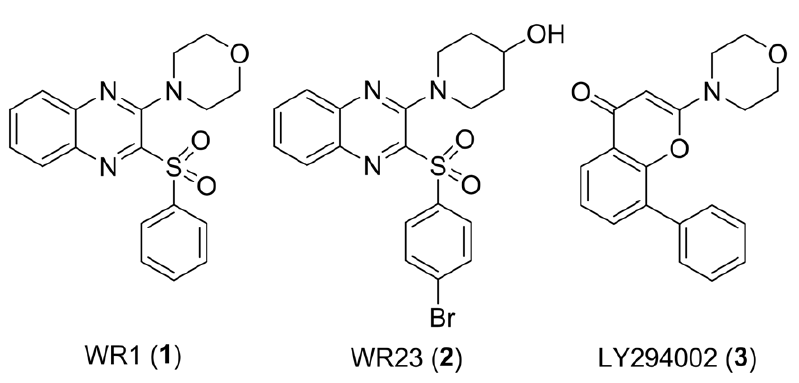
Figure 1. Morpholinoquinoxaline WR1, piperidinylquinoxaline WR23, and LY294002.